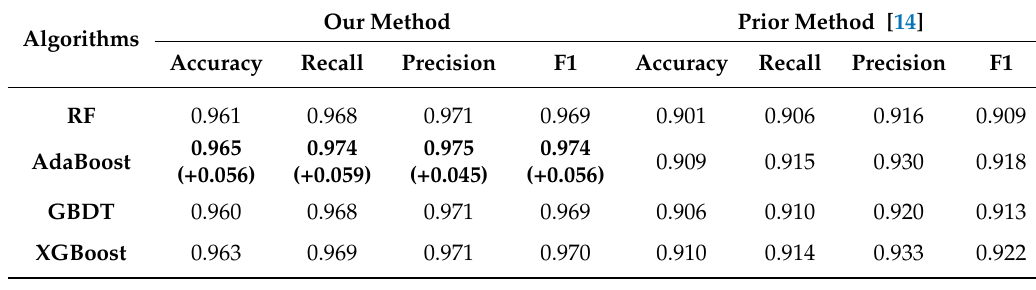
Table 5. Results of action identification on the Alipay app.